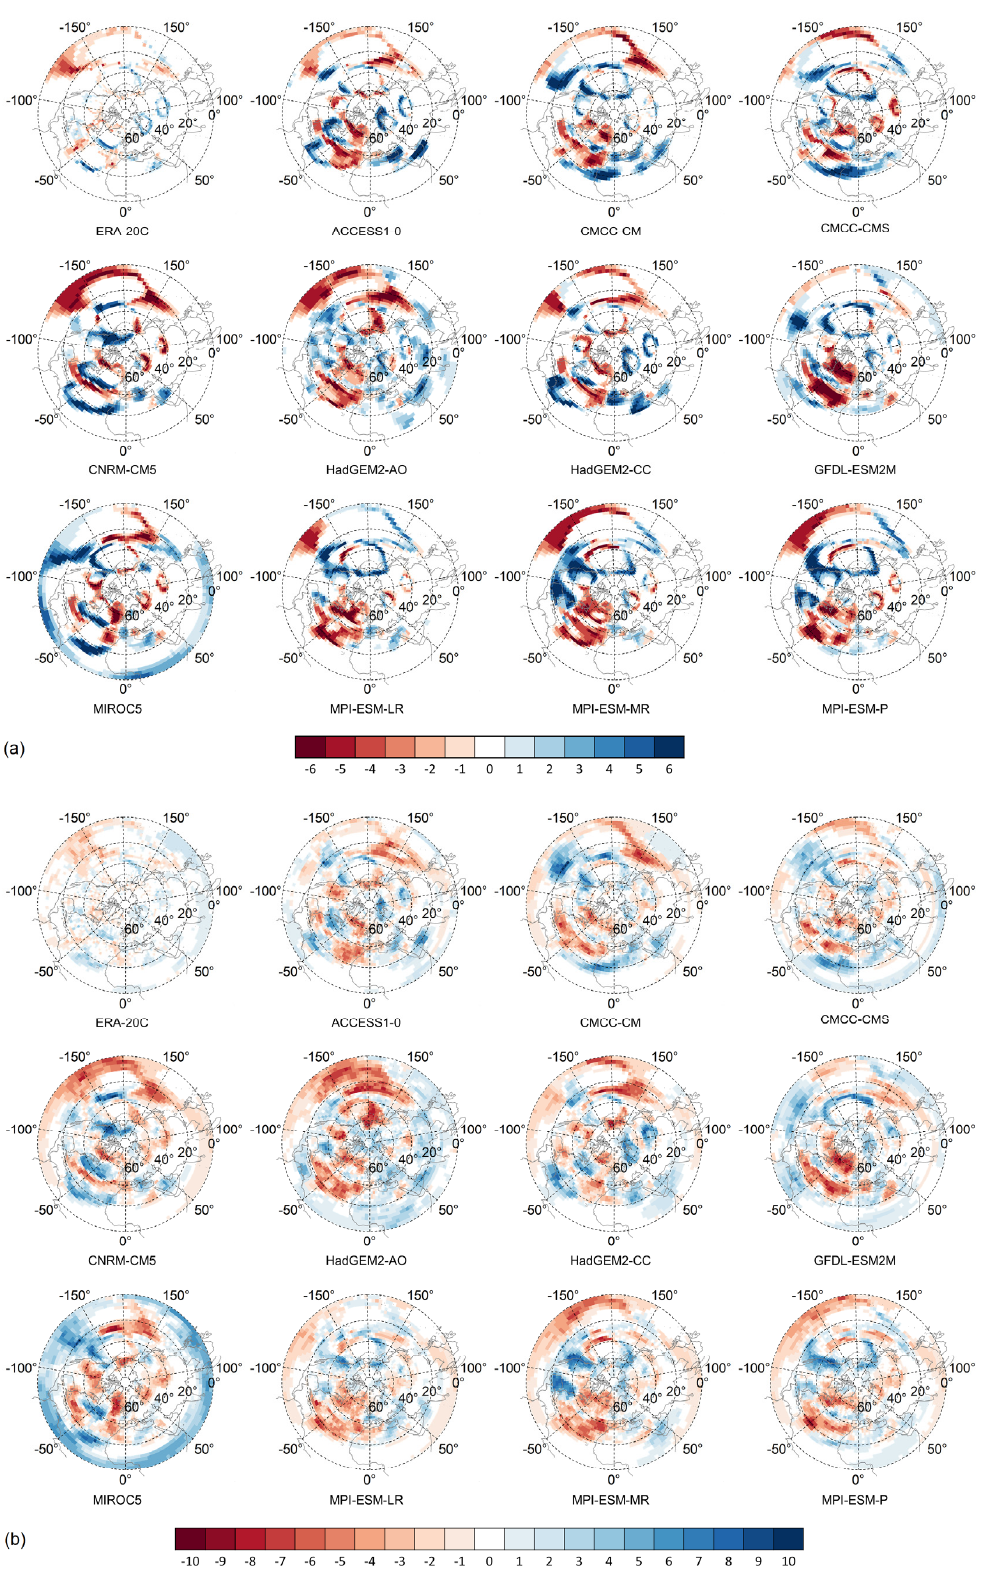
Figure 3. Difference maps of selected reanalyses/GCMs based on the NCEP-NCAR R1. Difference of the number of periods with the strongest negative correlation below the 25th percentile of all correlations in the given reanalysis/GCM per grid cell ( a ) in the case of the 30-year-long periods and ( b ) in the case of the 10-year-long periods.